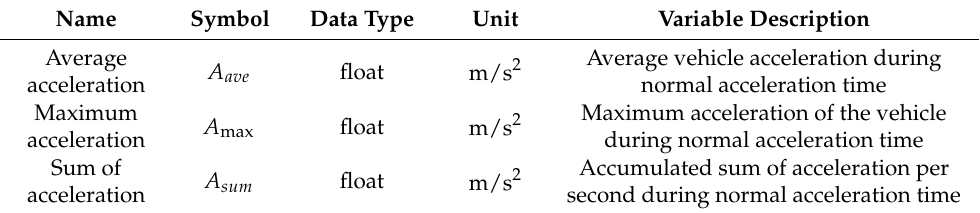
Table 4. Intermediate variables of average acceleration and maximum acceleration